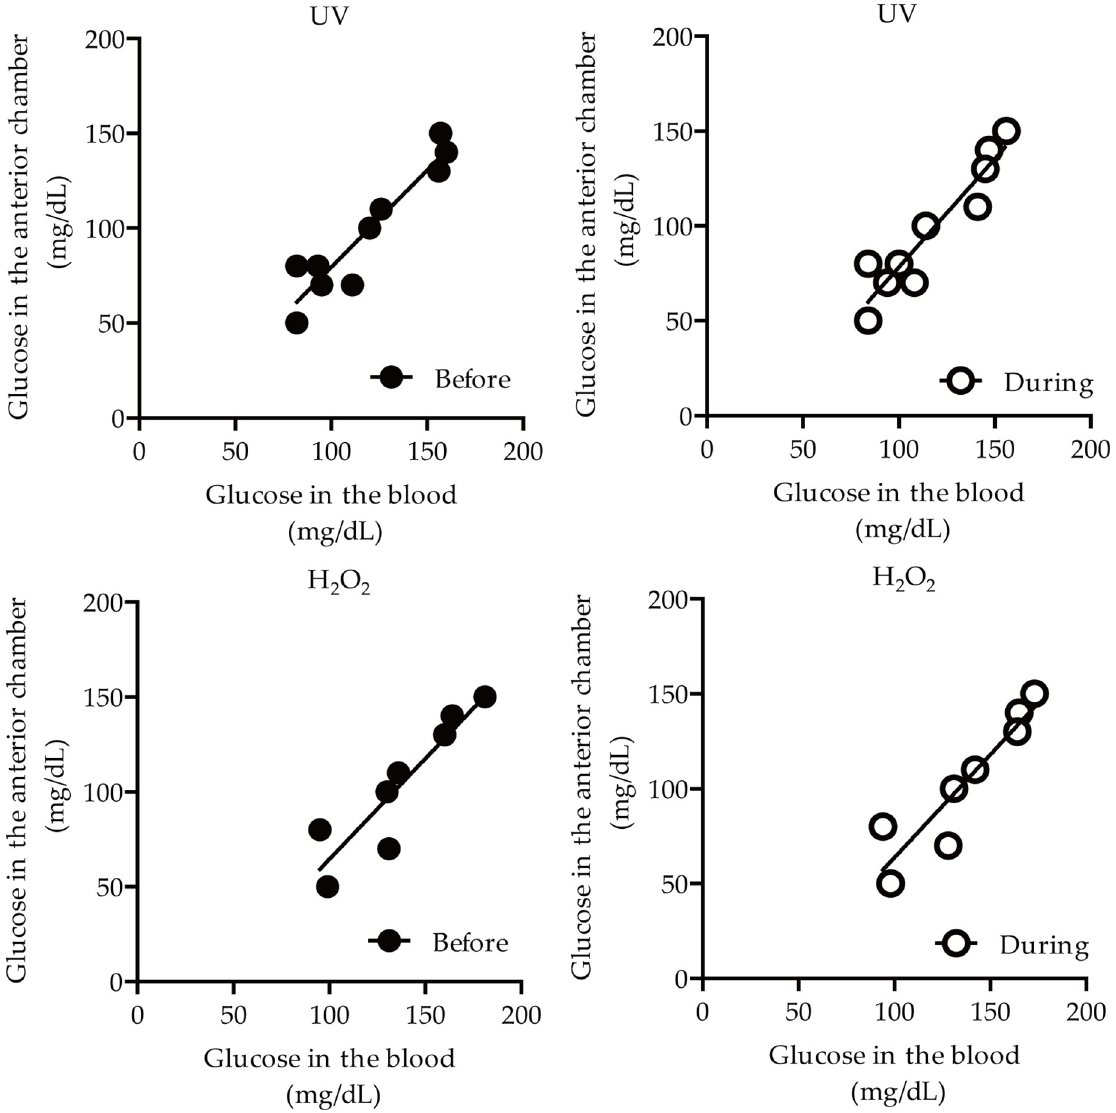
Fig 2. Visualization of a correlation on glucose levels between the anterior chamber and blood in Study 1 subjects with cataracts based on the values in Table 2. Dots represent the measured glucose levels. Lines represent the linear fit of the data points. UV: UV-hexokinase method; H 2 O 2 : H 2 O 2 -electrode